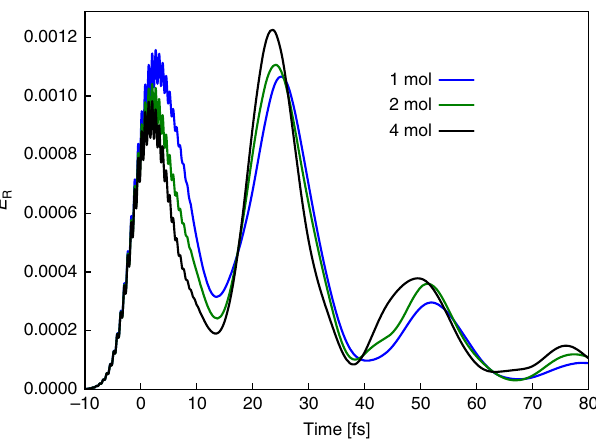
Fig. 5 Multiple molecules. Comparison of the radiative emission for different numbers of molecules coherently coupled to the same cavity mode while keeping the total Rabi splitting Ω green, and black lines correspond to 1, 2, and 4 molecules, respectively. The frequency of the laser pulse is ω L = 3.3 eV and its bandwidth is σ = 0.15 eV. L γ = 0.1 and 0.3 eV (solid red and dashed dark red lines in c